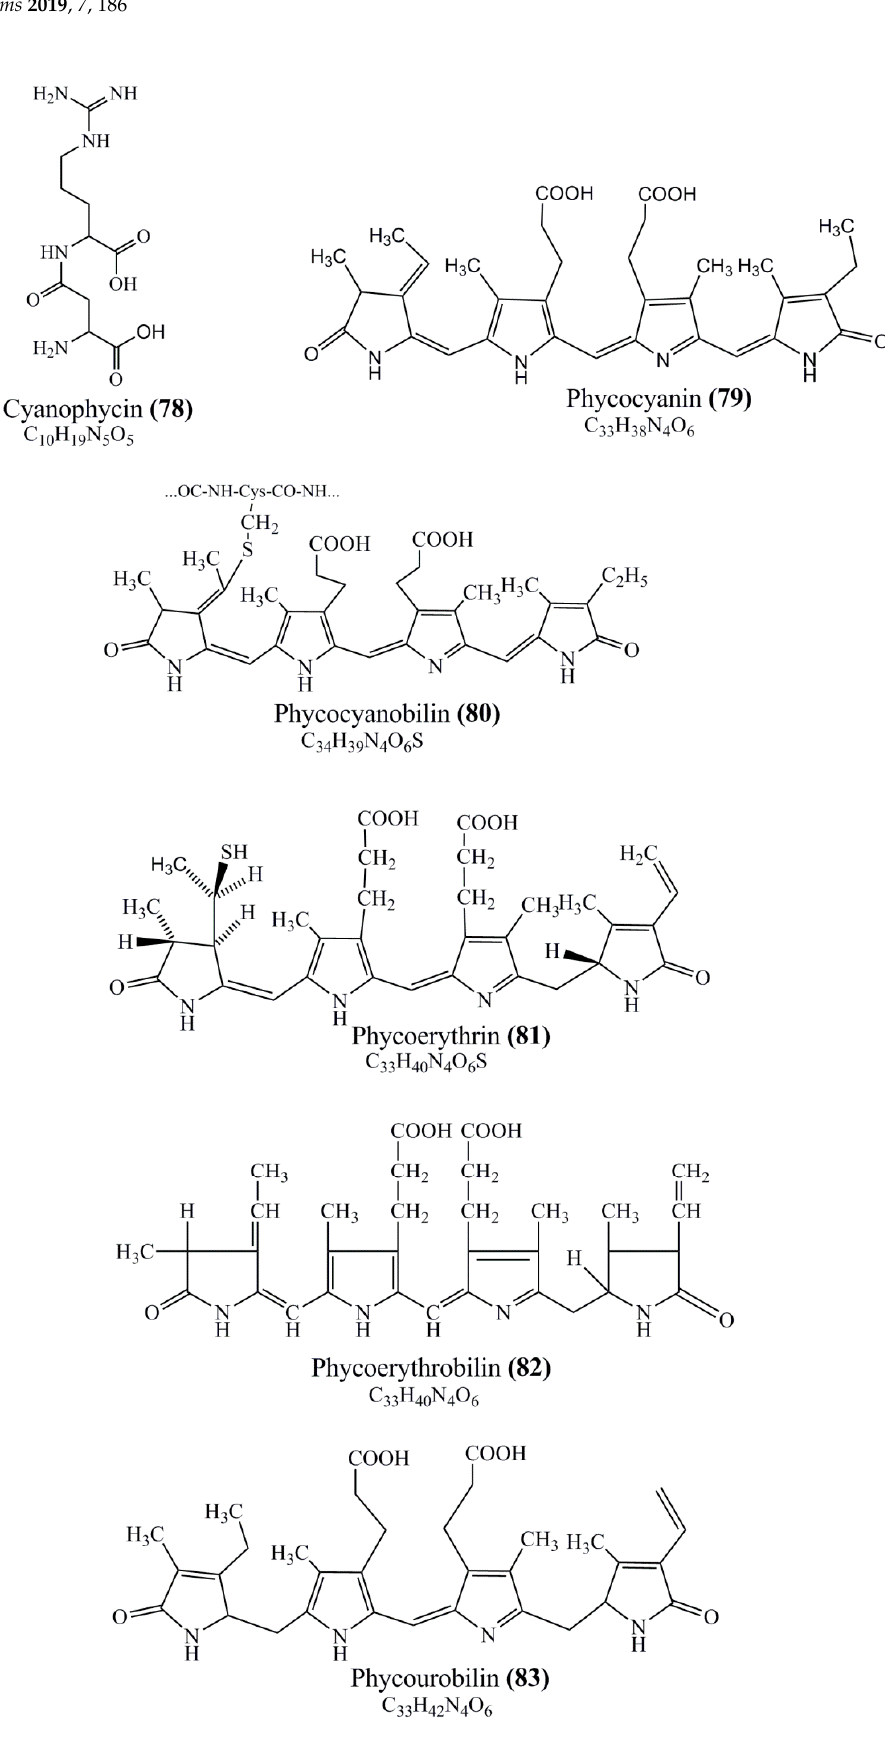
Figure 1. Figure 1. Continued.